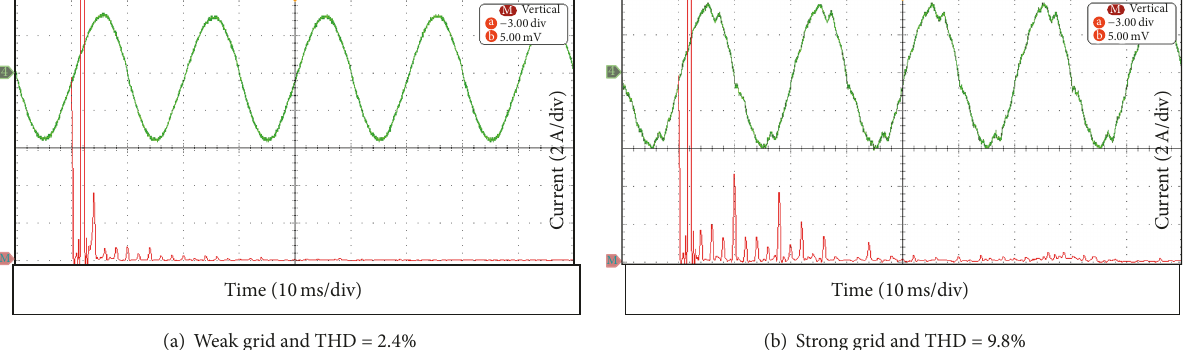
Figure 12: Output current waveform and its FFT analysis at varying inductor as in (a) and (b).